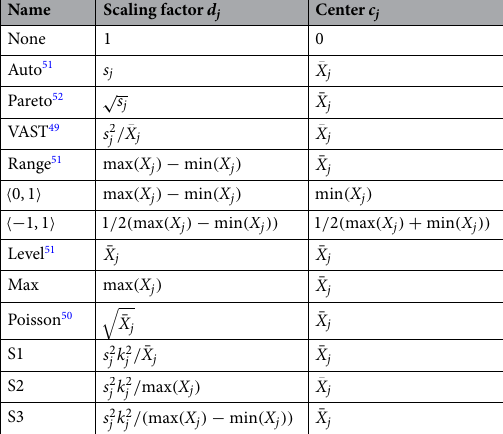
Table 1. Data scaling techniques used in this work.